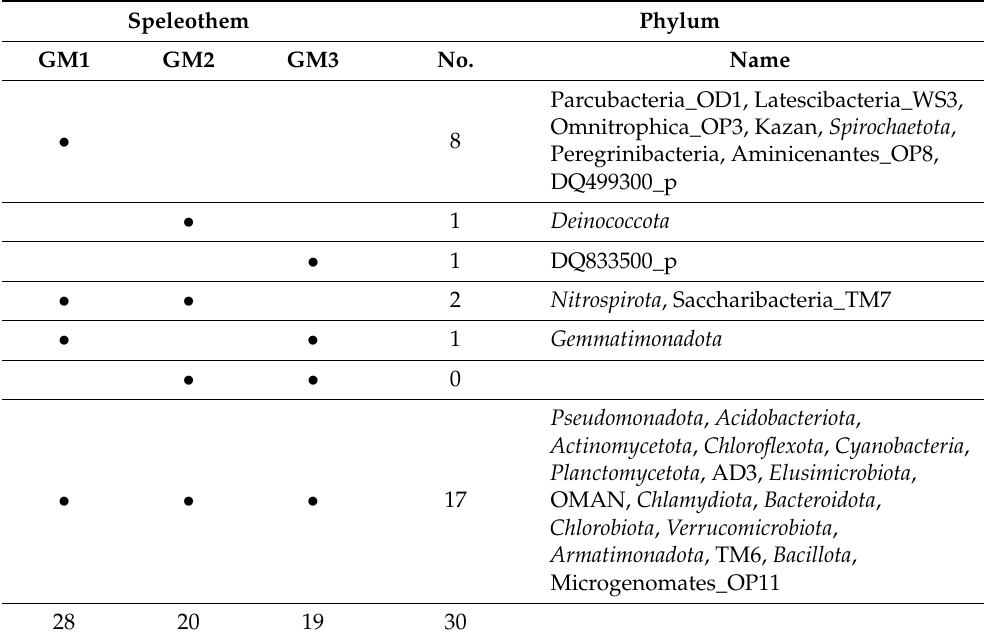
Table 2. Names of phyla in relative compliments and intersections of the Venn diagram (Figure 7). Valid names and candidatus taxa are shown in italic (oblique) and roman (upright) styles, respectively, in the order of read abundance.